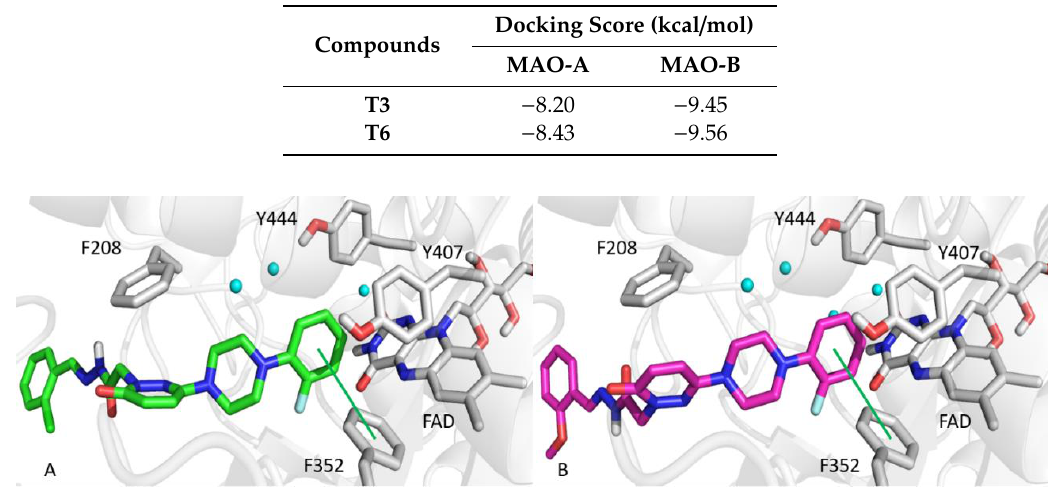
Figure 5. Top scored poses of T3 ( A , green sticks) and T6 ( B , magenta sticks) towards MAO-A. Green lines show π - π interactions. Water molecules are rendered as cyan spheres.